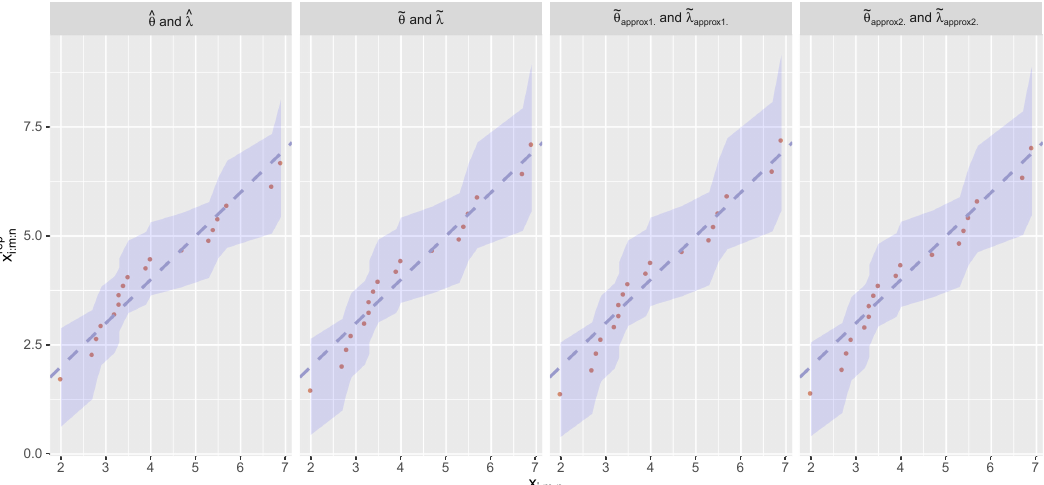
Figure 3. 95% predictive regions for X rep Type-II censored sample and E ( X rep